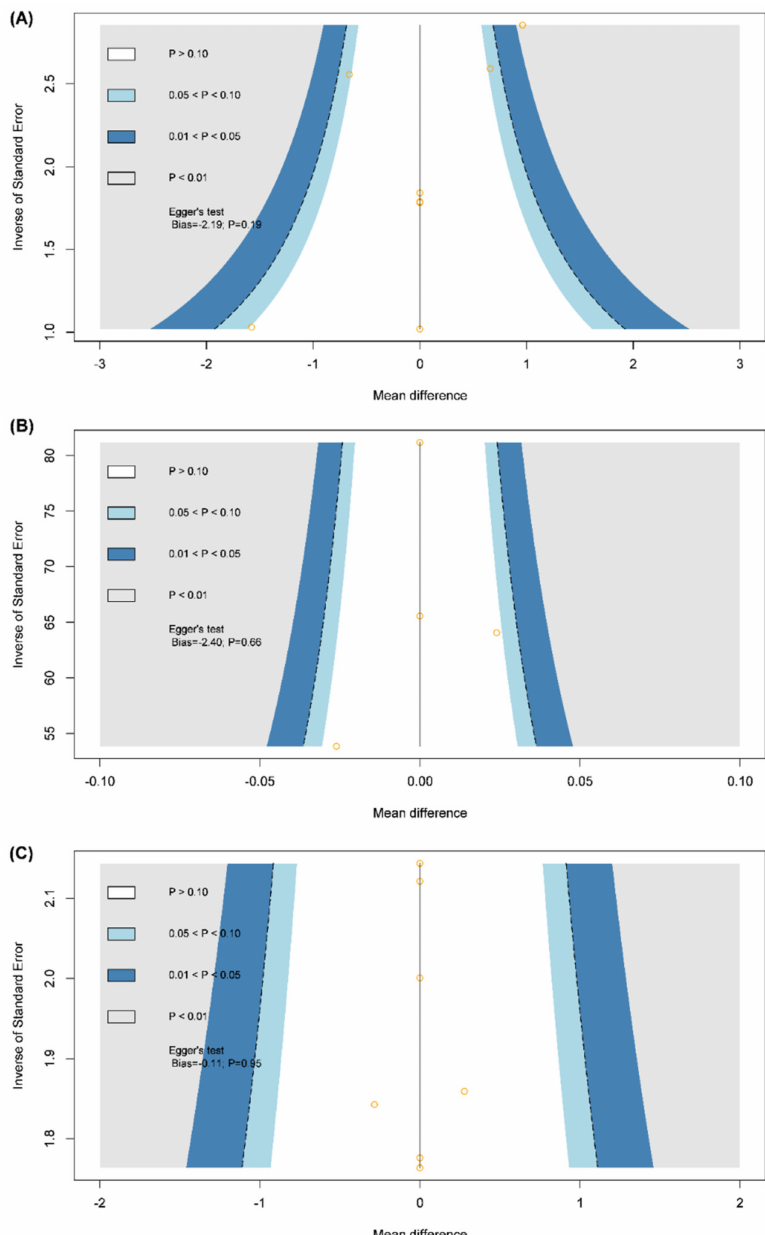
Figure 4. Funnel plots of ( A ) change in hand grip, ( B ) change in gait speed, and ( C ) appendicular muscle